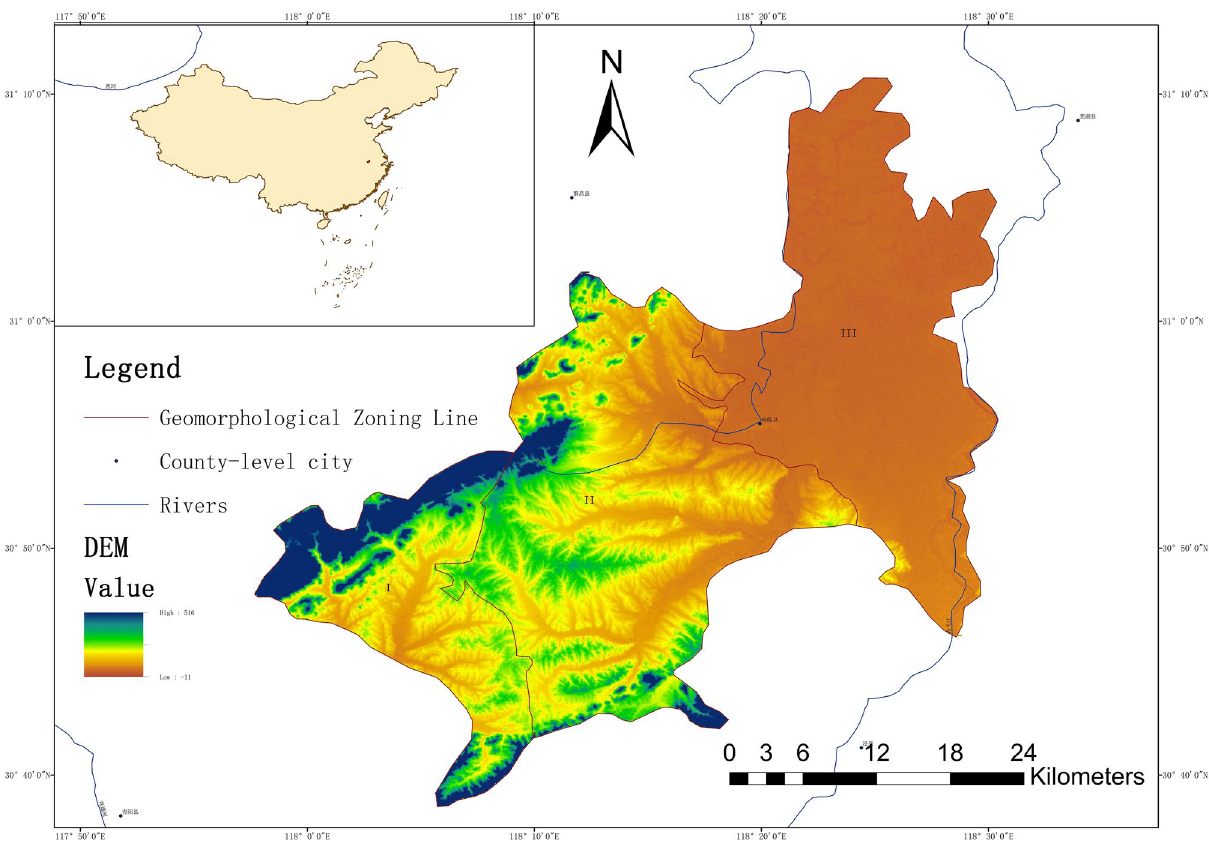
Figure 6. Topographic and geomorphological maps of Nanling area (Mapgis 6.7 http:// 10. 90. 90. 90/#/ portal/